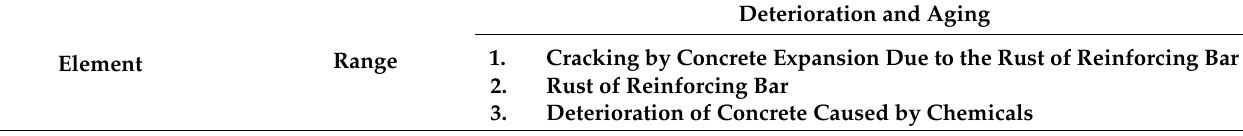
Table 1. Evaluation of T